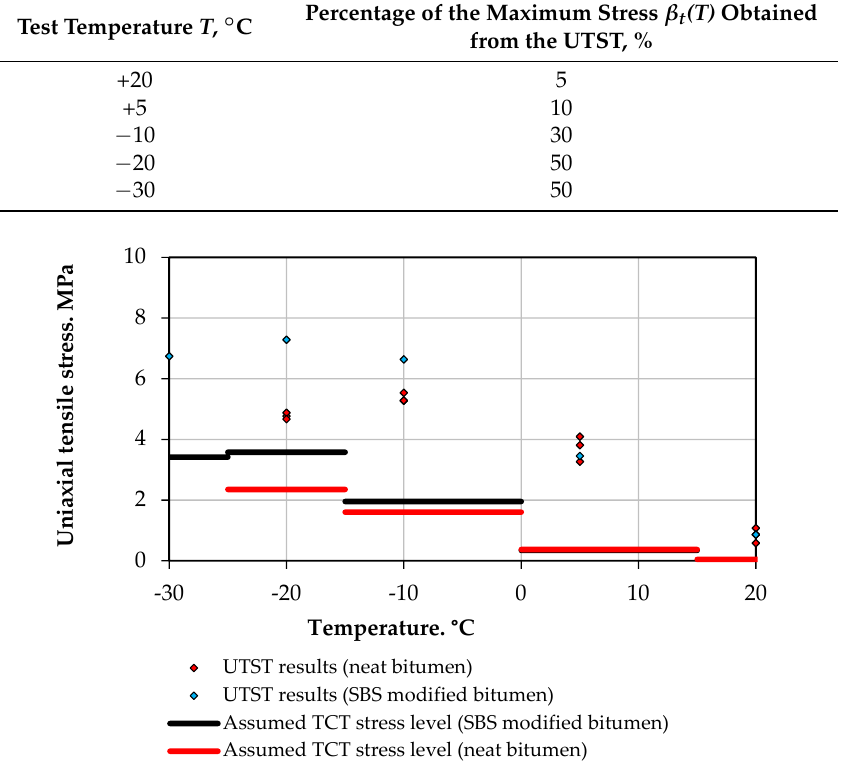
Table 3. Test conditions for the Tensile Creep Test (TCT), [49].